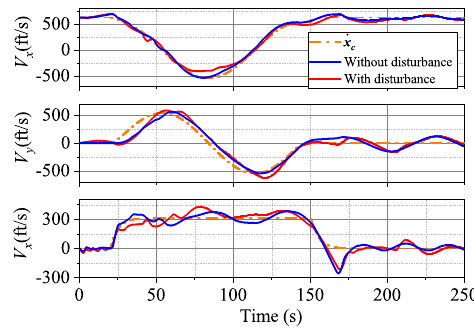
Figure 7. Results for v x , v y , and v z .